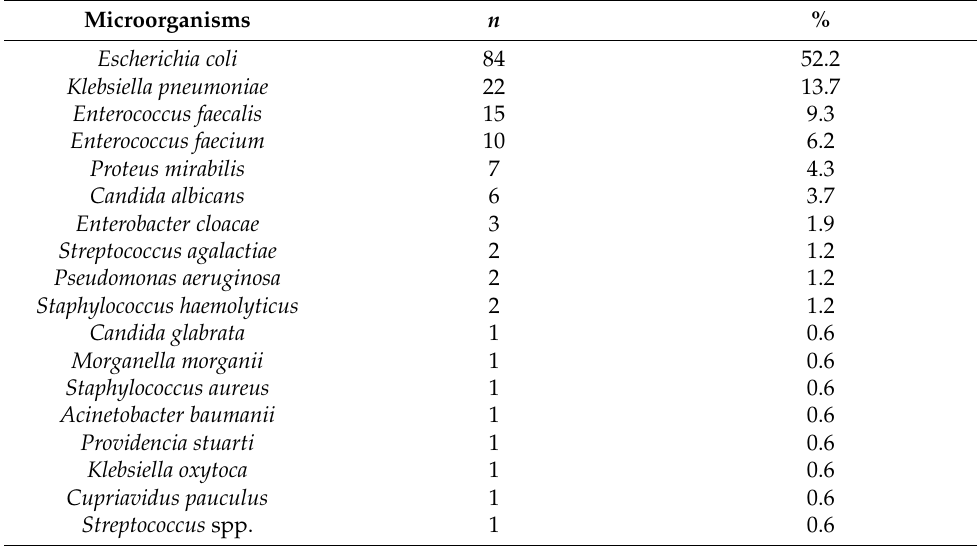
Table 2. Distribution of microorganisms isolated from urine samples.